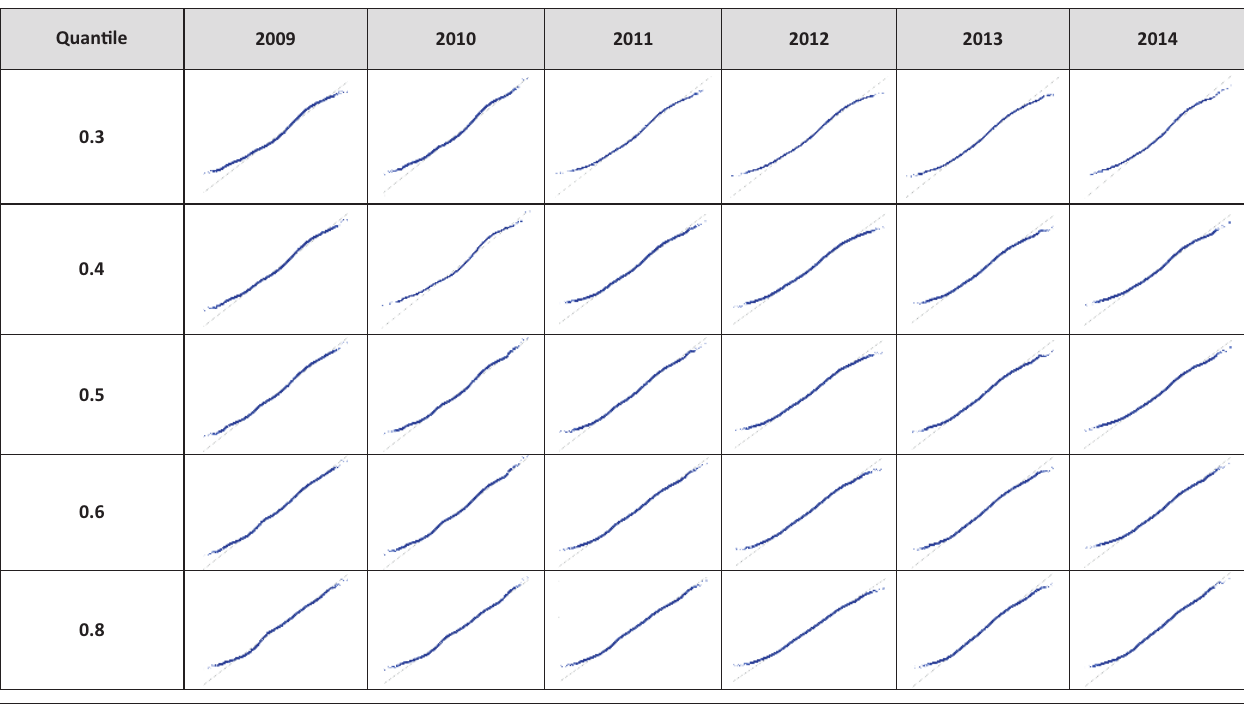
FIGURE 3: Diagnostic plots for the quantile regression